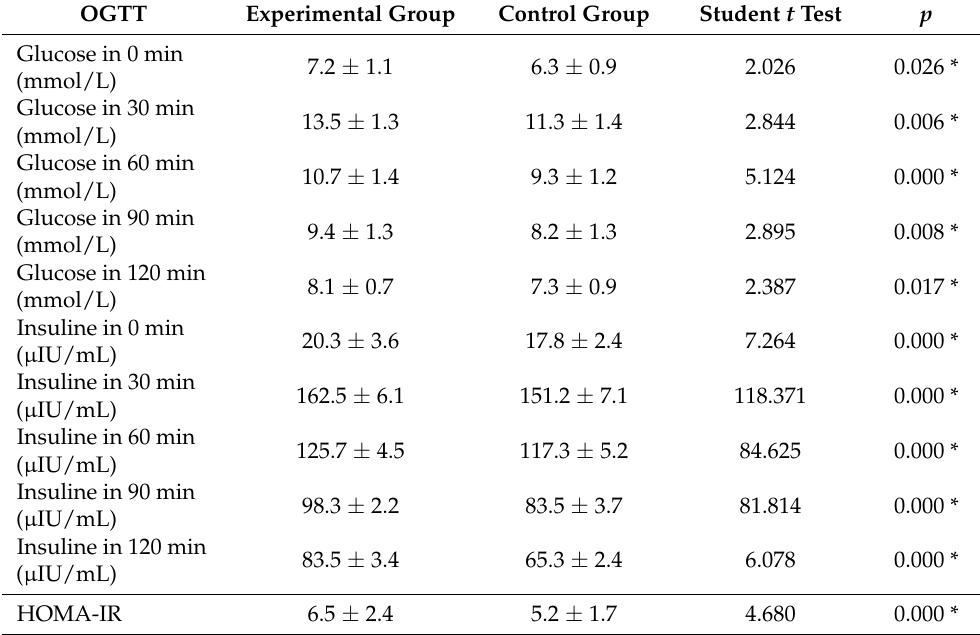
Table 5. Values of OGTT and HOMA-IR. OGTT Experimental Group Control Group Student t Test